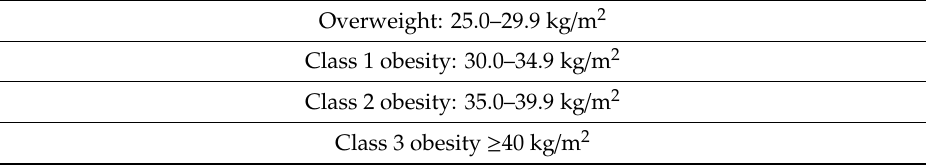
Table 1. Categories of overweight and obesity according to body mass index